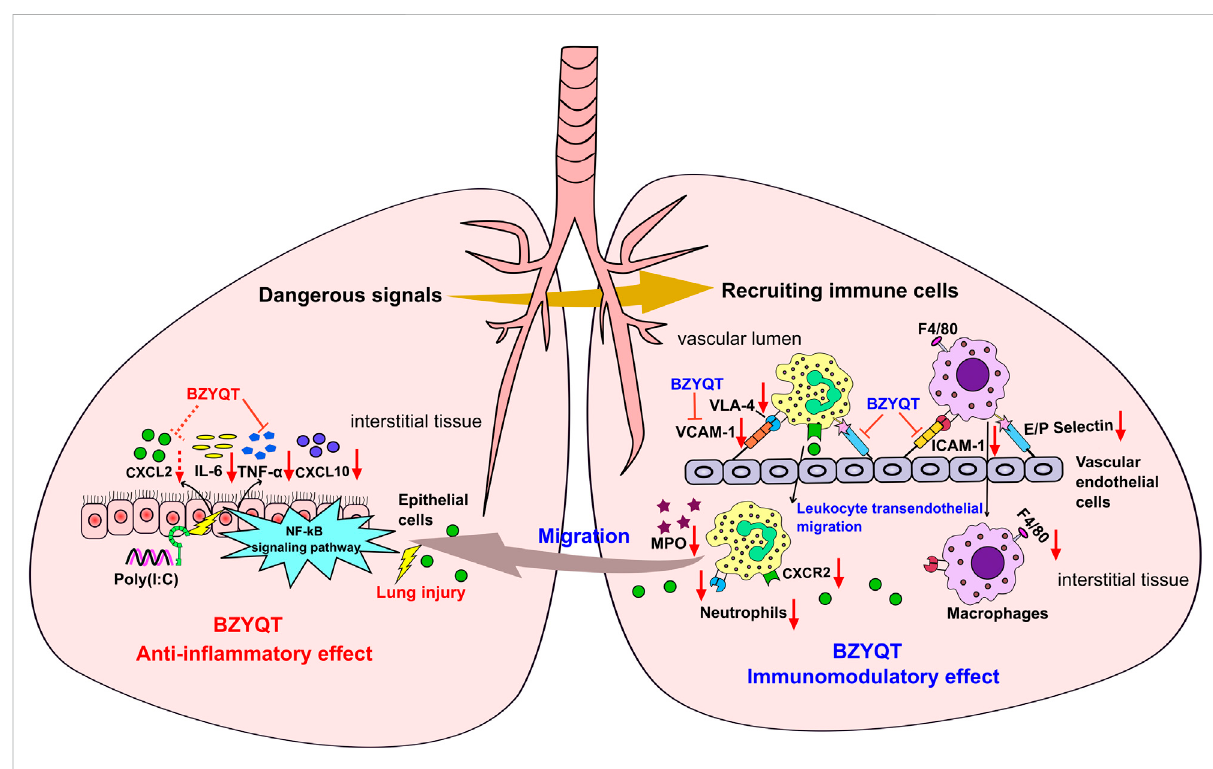
FIGURE 9 Potential mechanism of BZYQT for the alleviation of pulmonary in fl ammation caused by poly (I:C). The dashed line (arrow) indicates a